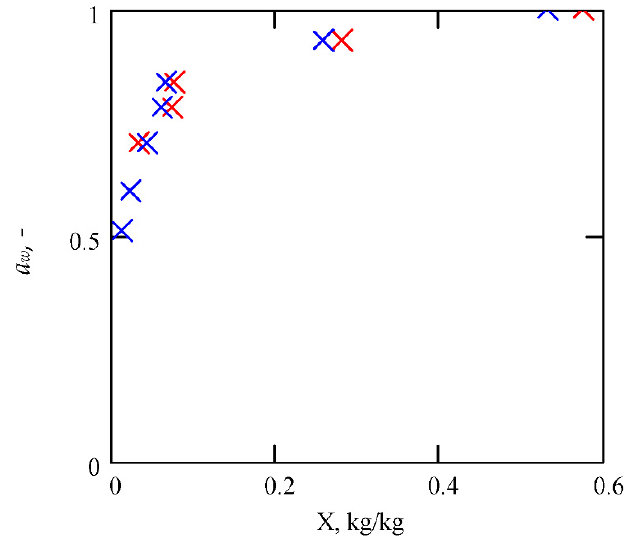
Figure 4. Data from Figure 3 replotted in a w vs. X coordinates (lamina only).